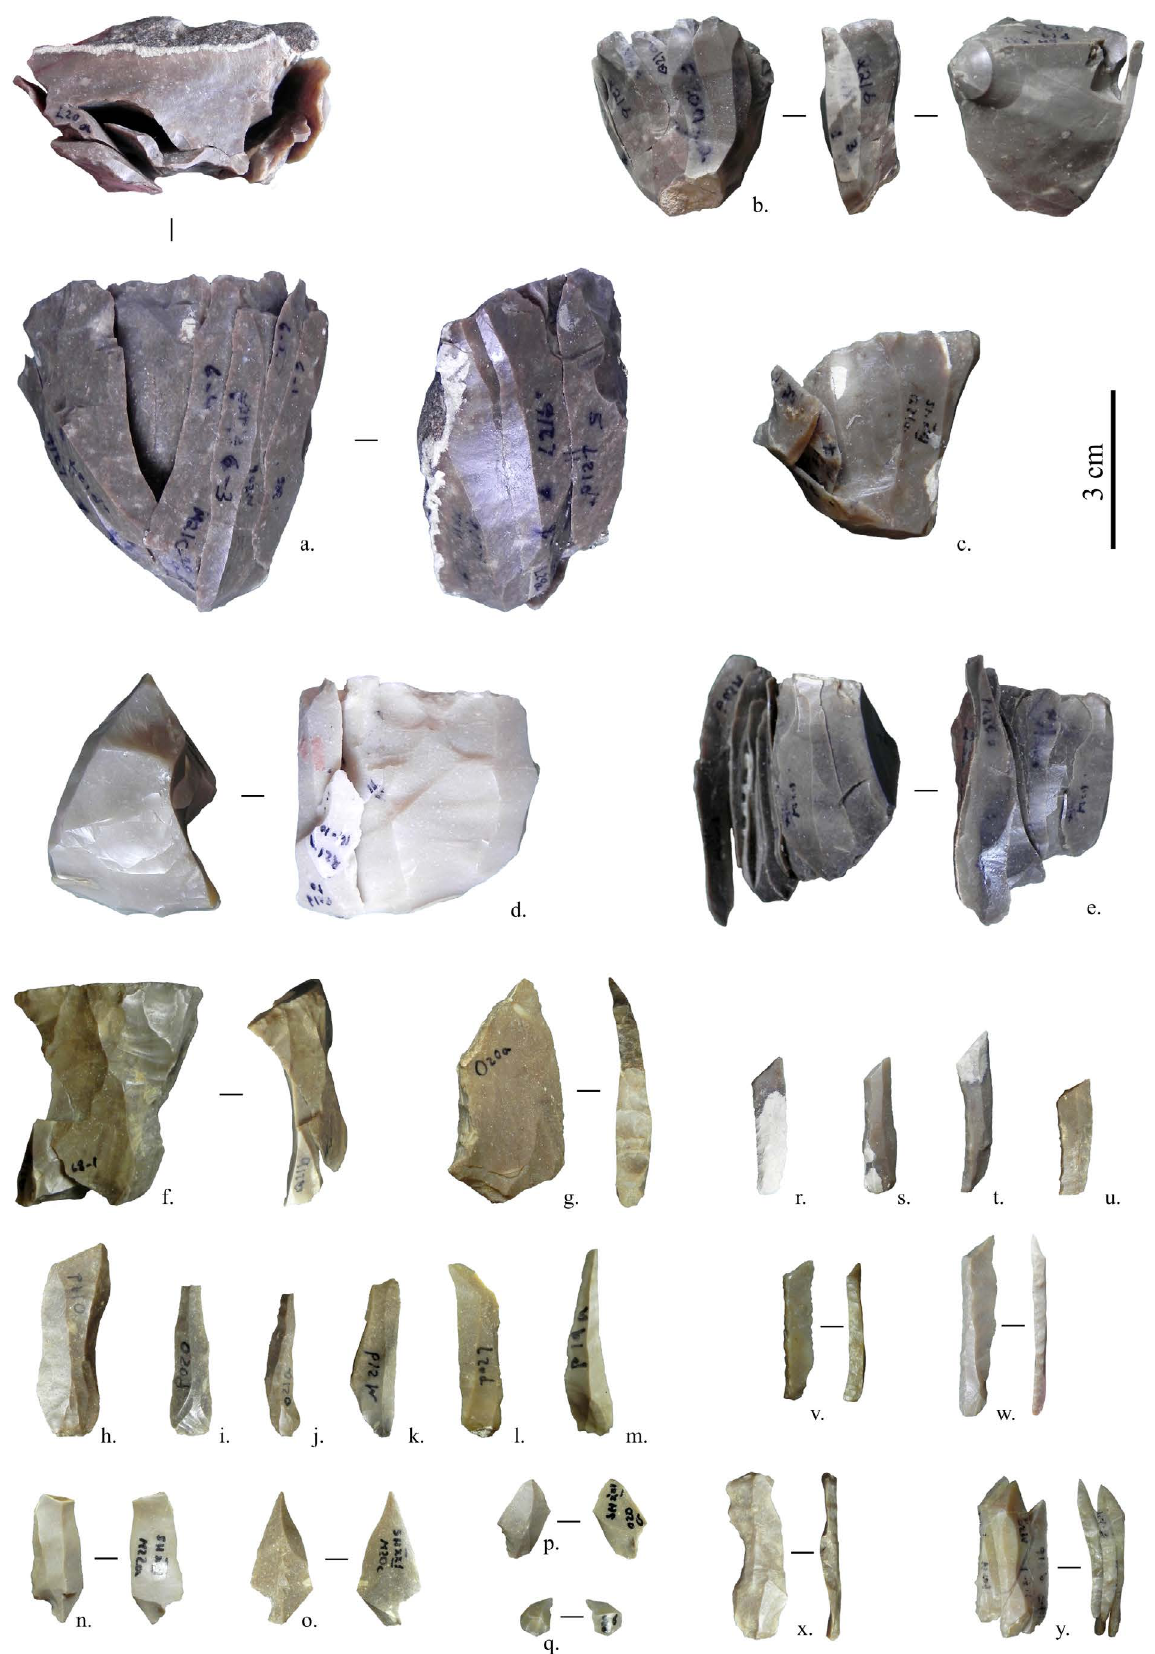
Figure 7. Shunera XXI - lithic artefacts. (a-e) cores, (f-g) core trimming elements, (h-m) elongated blanks, (n-q) microburins, (r-w) ramon points, x = unfinished microlith, y = refitted cluster of